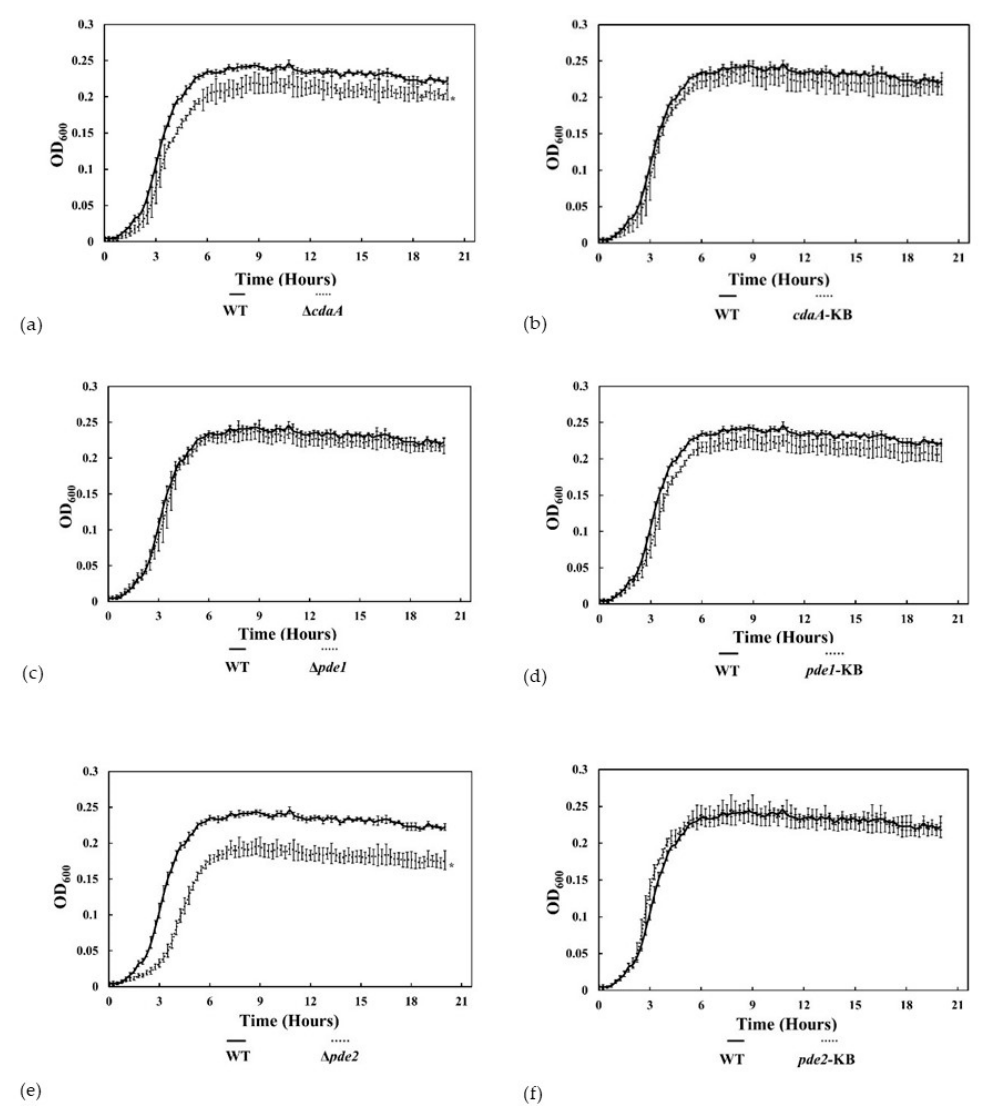
Figure 6. Disruption of the c-di-AMP signaling network affects growth in liquid culture. ( a – f ) Cultures were incubated in a plate reader and the optical density at 600 nm (OD 600 ) was measured every 15 min for 20 h. Data are the mean of two independent experiments. * indicates statistically significant difference compared to WT. Error bars represent 95% confidence interval.